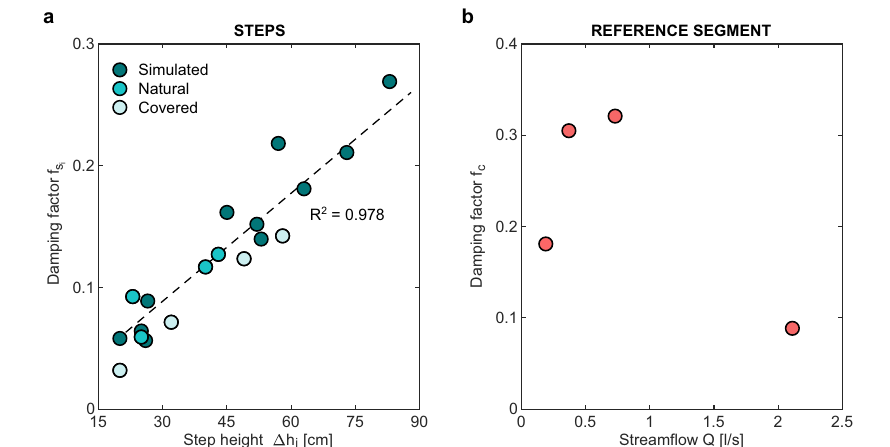
Fig. 3 | Damping factors for the steps and the reference segment. a damping regressionthroughtheleastsquaresapproachonthedata( n =19, p -value<0.001). ,asafunctionofthestepheight Δ h i forscourednaturalsteps factorofthestep i , f s R 2 =0.978 is the coef fi cient of determination of the linear regression. b damping i ,fordifferentdischargeconditionsintherange (cyancircles),naturalcoveredsteps(celestecircles)andarti fi ciallysimulatedsteps factorinthereferencesegment, f c r from 0.19 to 2.11 l / s (greencircles).Thedashedlinerepresentsthelinearrelation f s =0 : 3 Δ h i (95%CIof i slope: 0.27,0.32), with Δ h i in m , which was obtained by fi tting a simple linear